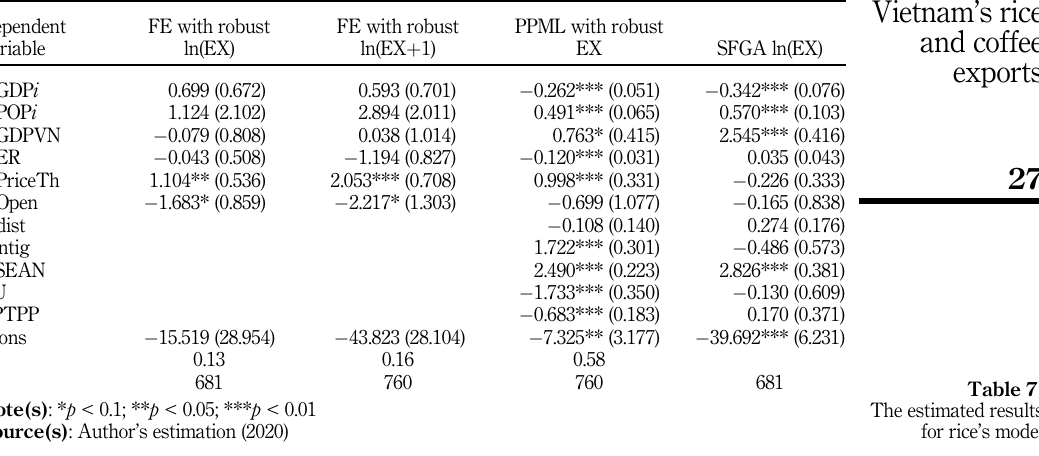
Table 7. The estimated